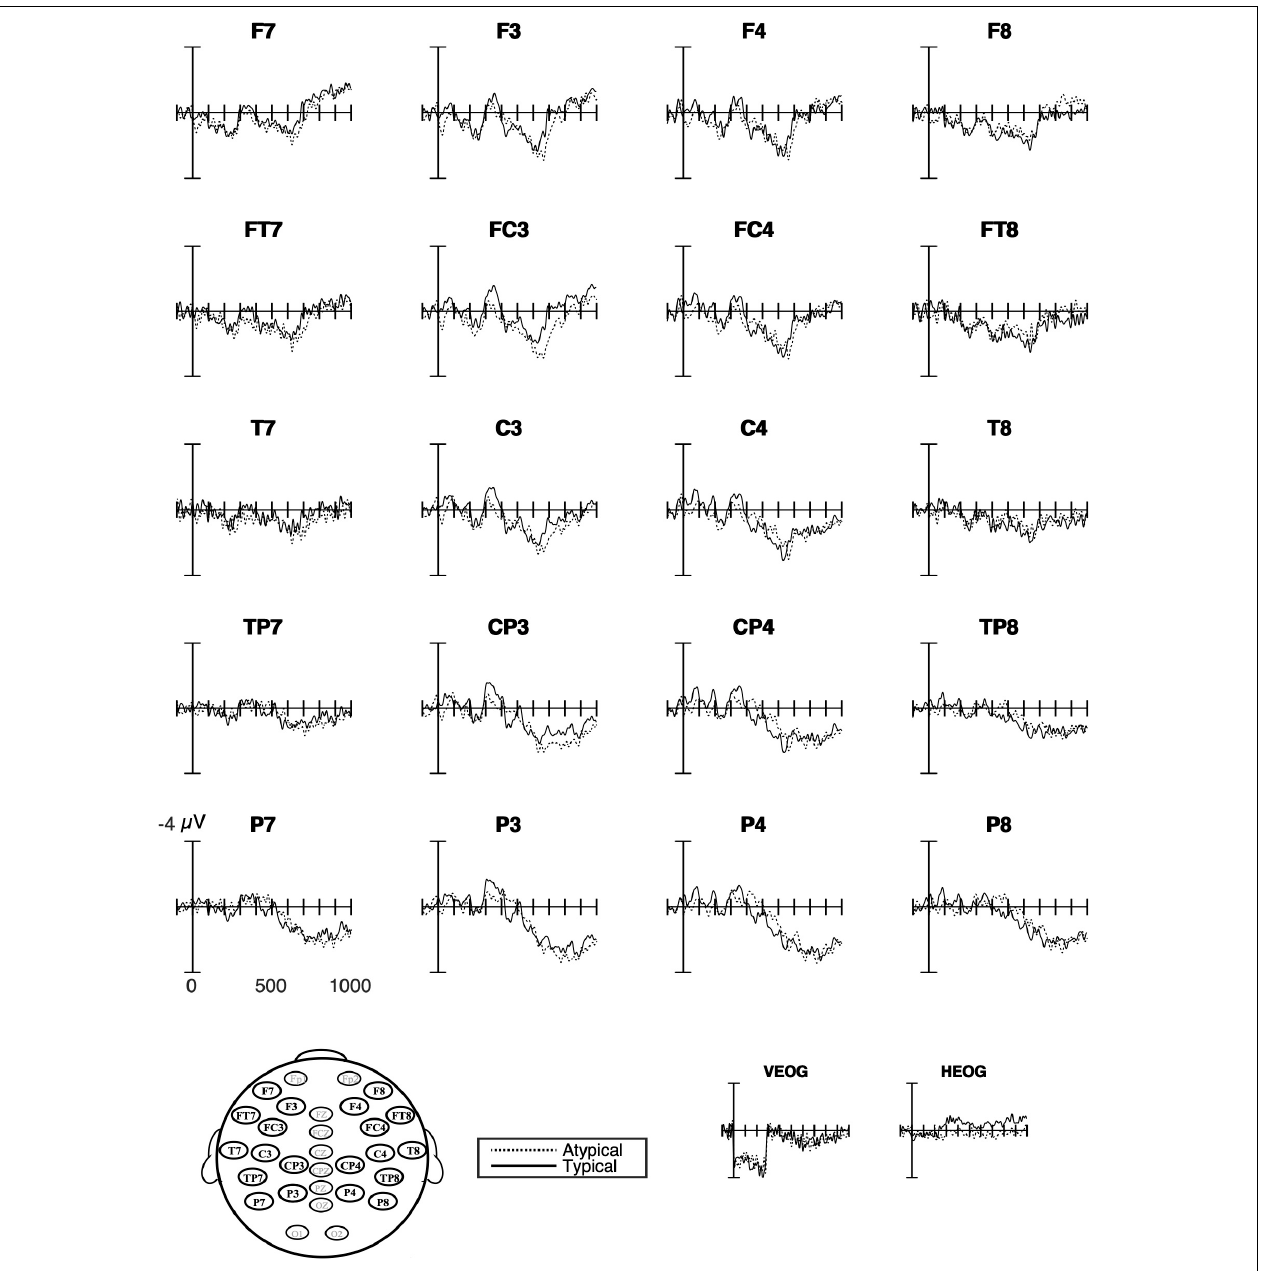
FIGURE 8 | Grand average ERPs for German learners. The response to typical verb use (number of trials in the bin, n = 546) as solid lines and to atypical verb use ( n = 551) as dashed lines. The waveforms suggest a right lateral anterior negativity (F8 and FT8) for the atypical use of placement verbs and over posterior sites and a right negativity (e.g., P4) followed by a positivity strongest over left medial parietal sites.